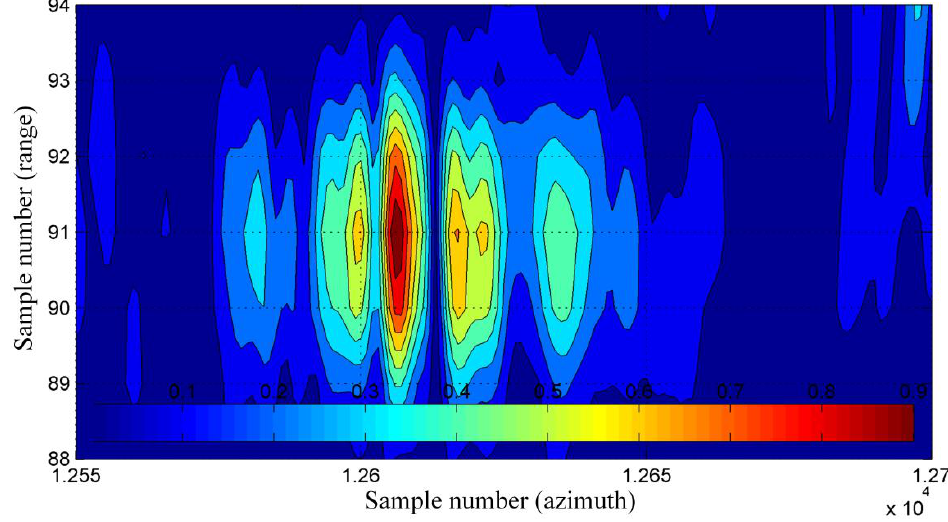
Figure 18. Normalized amplitude of corner reflector with INS/GPS-based MOCO.